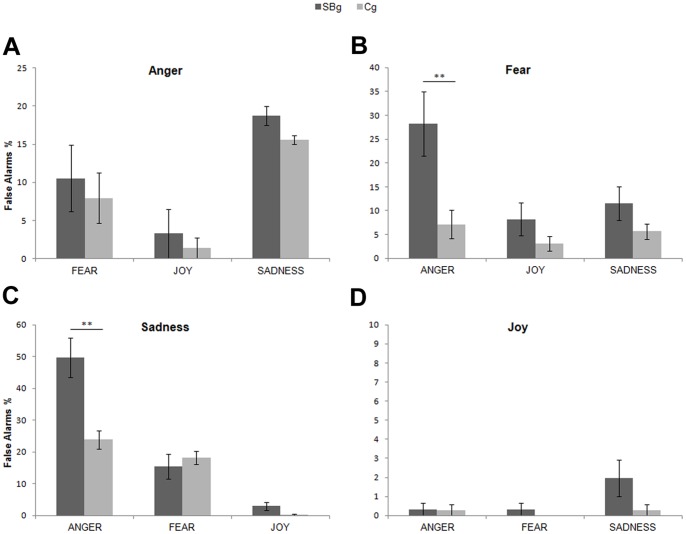
False Alarms.False Alarms rate displayed condition by condition for Street-Boys group (SBg) and Control group (Cg). ** = p<0.005. Only differences between groups were showed. See the text for differences inside each group. Error bars are SE.